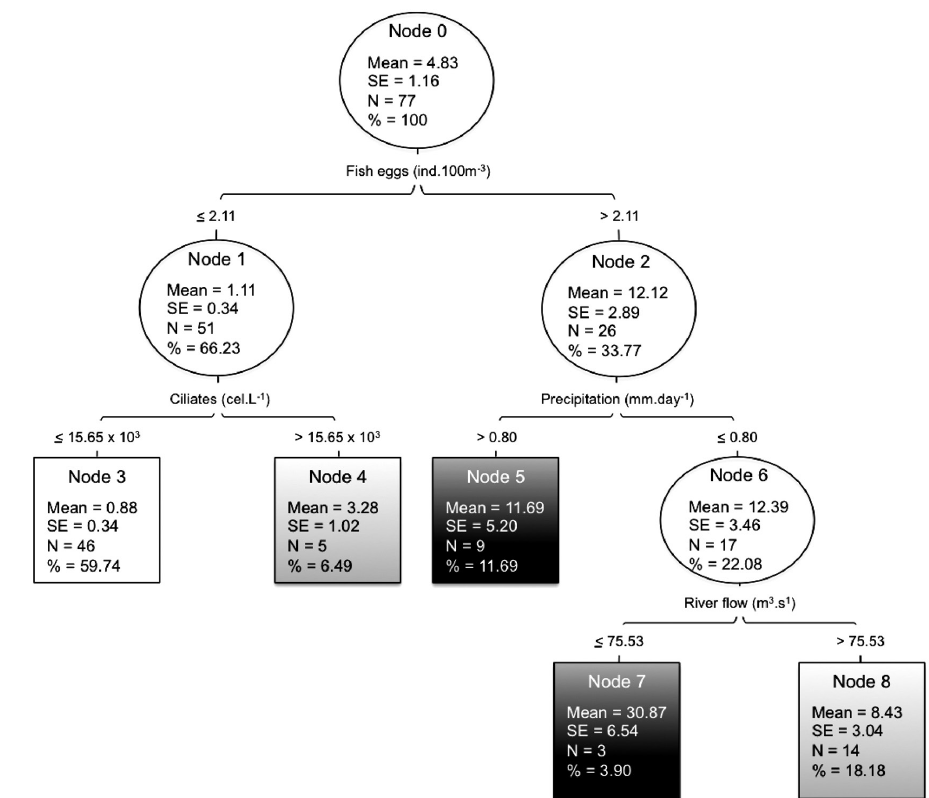
Fig. 6. – Single-target DT predicting the abundance of fish larvae along the Lezíria salt marsh creek. Each node indicates mean and standard error (se) of larvae abundance (ind./100 m 3 ); total number of larvae per node (N) and percentage of larvae per node (%). Squares represent final nodes with larvae abundance predictions. In grey scale: white for low abundance (<2 larvae/100 m 3 ), light grey for medium abundance (2-10 larvae/100 m 3 ), and dark grey for high abundance (>10 larvae/100 m 3